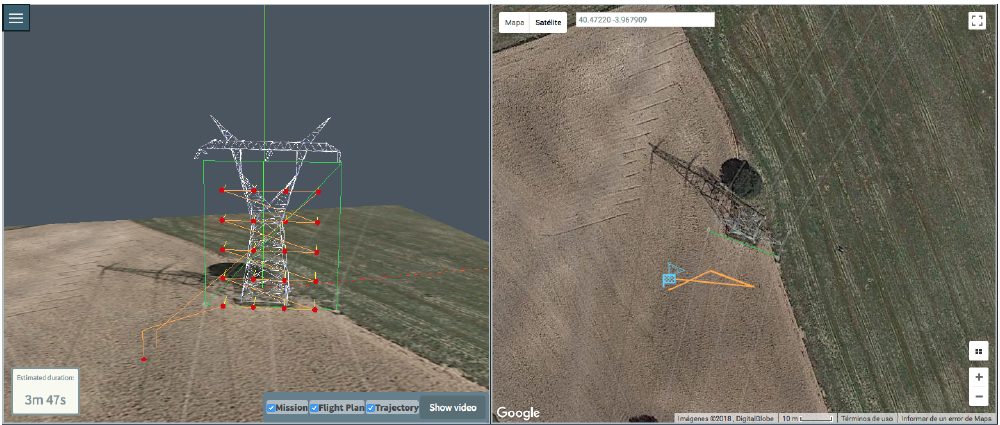
Figure 7. Generated Flight Plan and Trajectory views: ( left ) lateral ( right ) zenit.